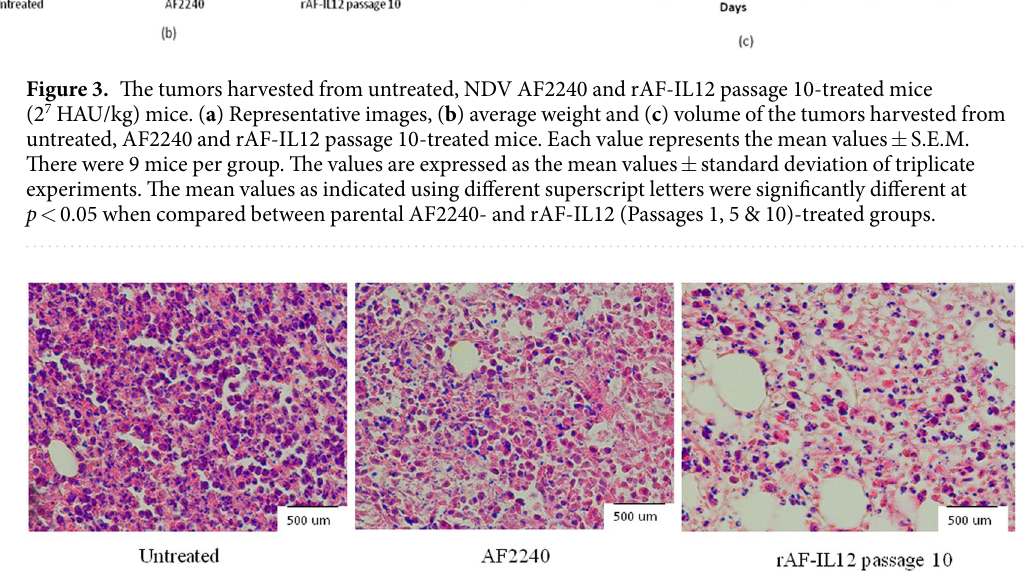
Figure 4. Histological staining (haematoxylin and eosin) of tumors from untreated, NDV AF2240- and rAF-IL12 passage 10-treated mice groups. Condensed round cells stained dark purple represent cells undergoing mitoses. Magnification: